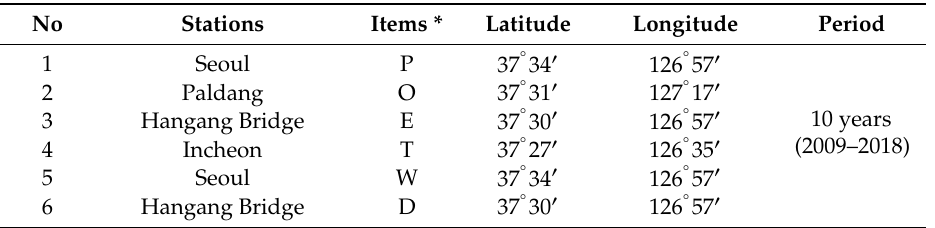
Table 1. Information about hydrological stations.